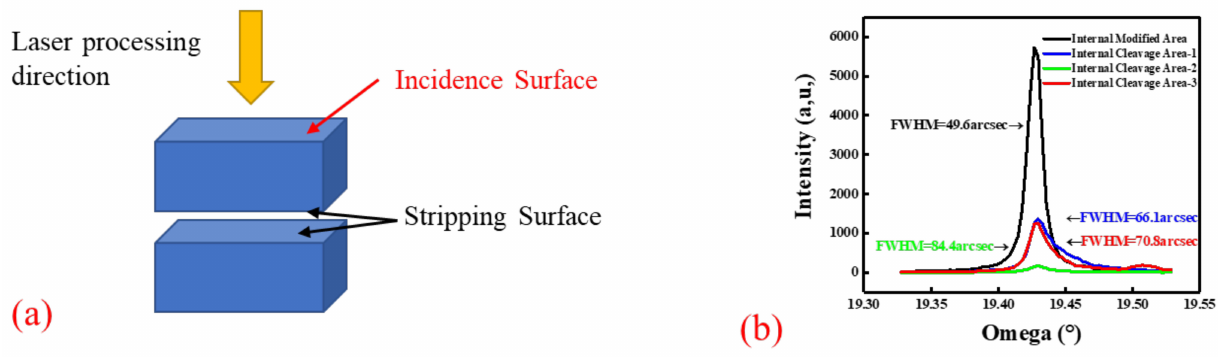
Figure 10. ( a ) Schematic diagram of test surface. ( b ) The X-ray double crystal diffraction rocking curve of the normal area and cleavage area of the incidence